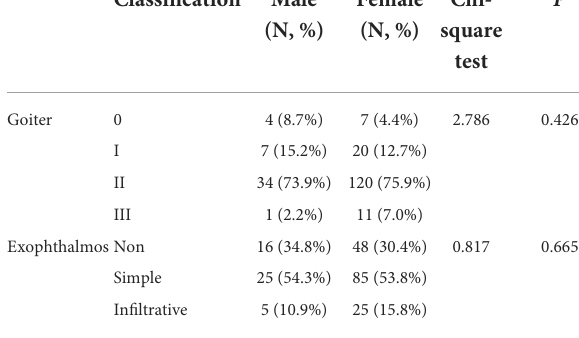
TABLE 2 The correlations between thyroid function and degree of goiter and exophthalmos.